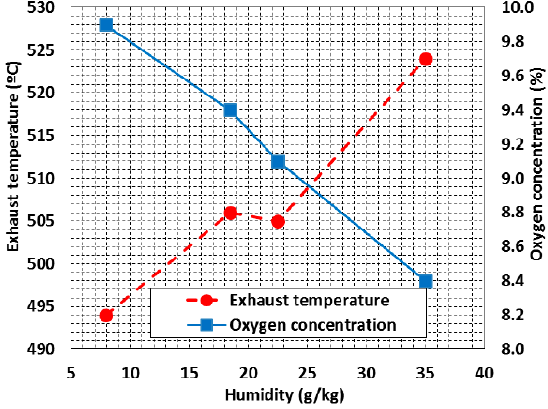
Figure 4. Effect of humidity on a high-speed diesel engine.